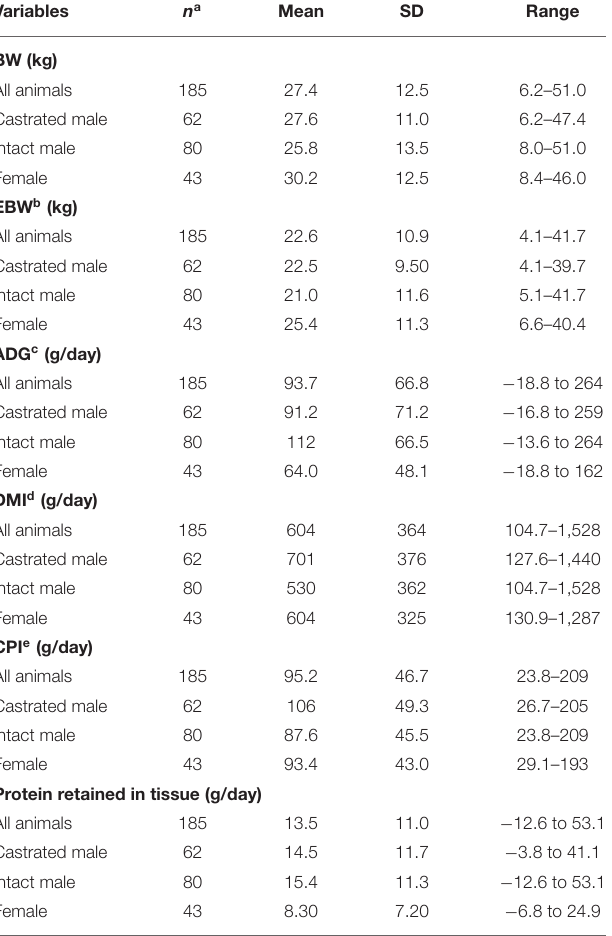
TABLE 2 | Summary of descriptive statistics of N balance in Saanen goats used in this study.